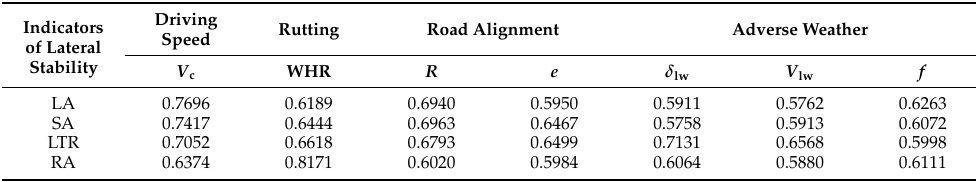
Table 5. Grey relational grade (GRG) of each